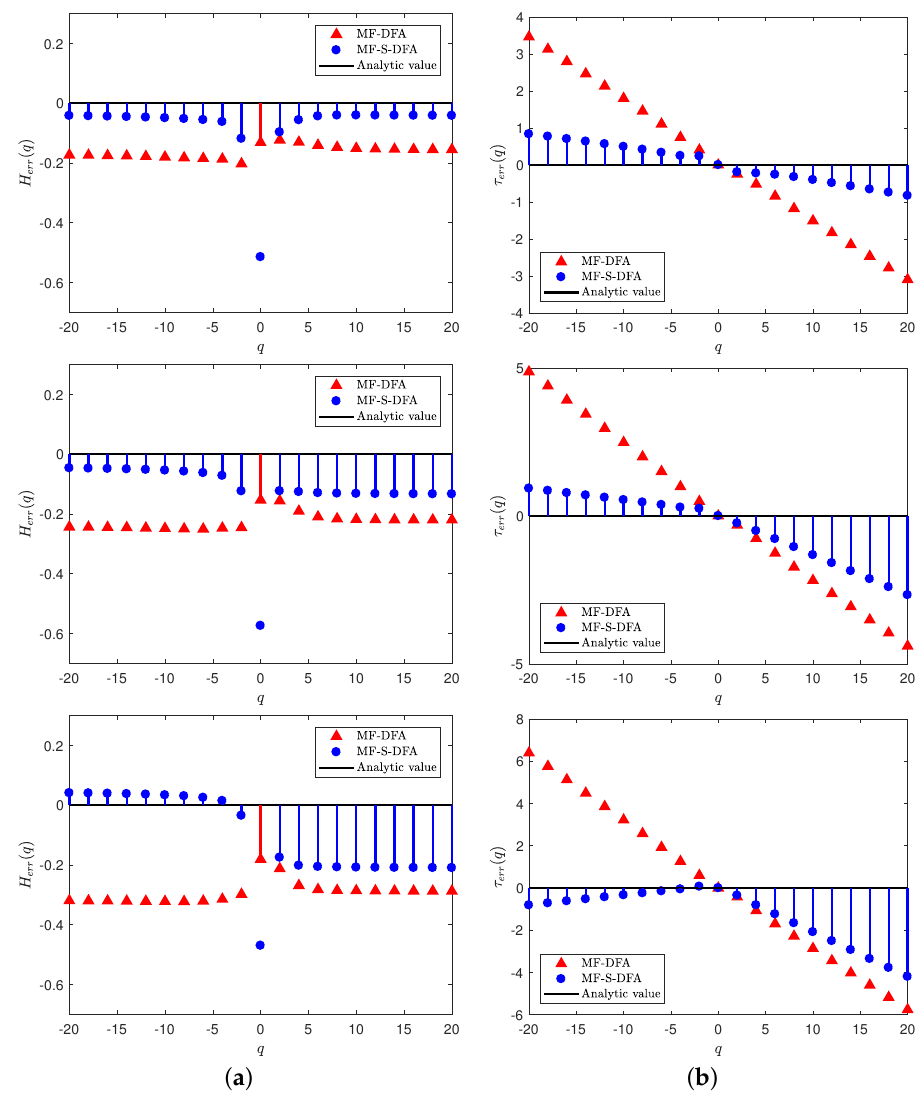
Figure 8. Comparison of MF-DFA and MF-S-DFA with theoretical values under different parameters p : ( a ) H err ( q ) and ( b ) τ err ( q ) . From top to bottom, p = 0.60, 0.65, 0.70, 0.75, 0.80 and 0.85, respectively. A color version of the figure is available in the web version of the article.